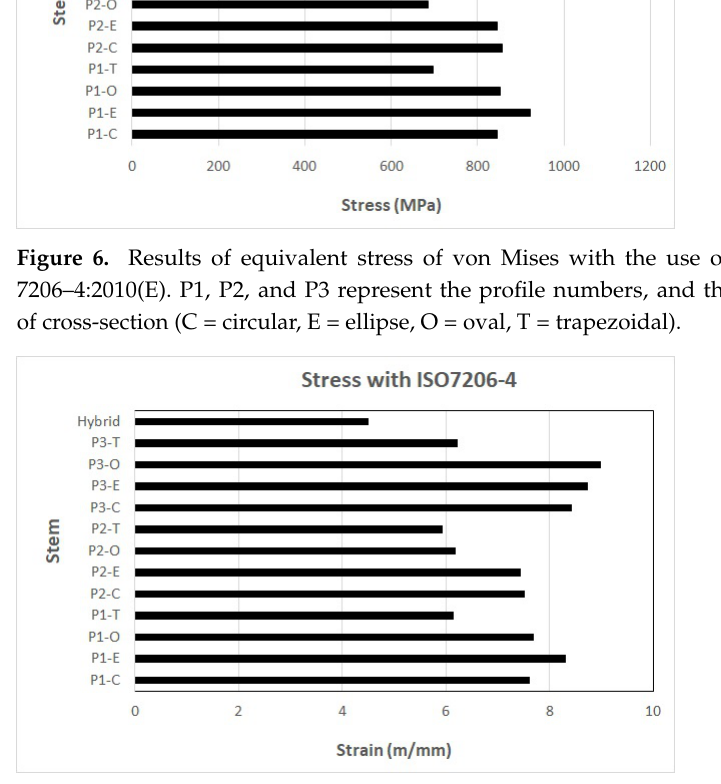
Figure 7. Results of equivalent strain of von Mises with the use of ASTM F2996-13 and ISO 7206–4:2010(E). P1, P2, and P3 represent the profile numbers, and the letter represents the type of cross-section (C = circular, E = ellipse, O = oval, T =